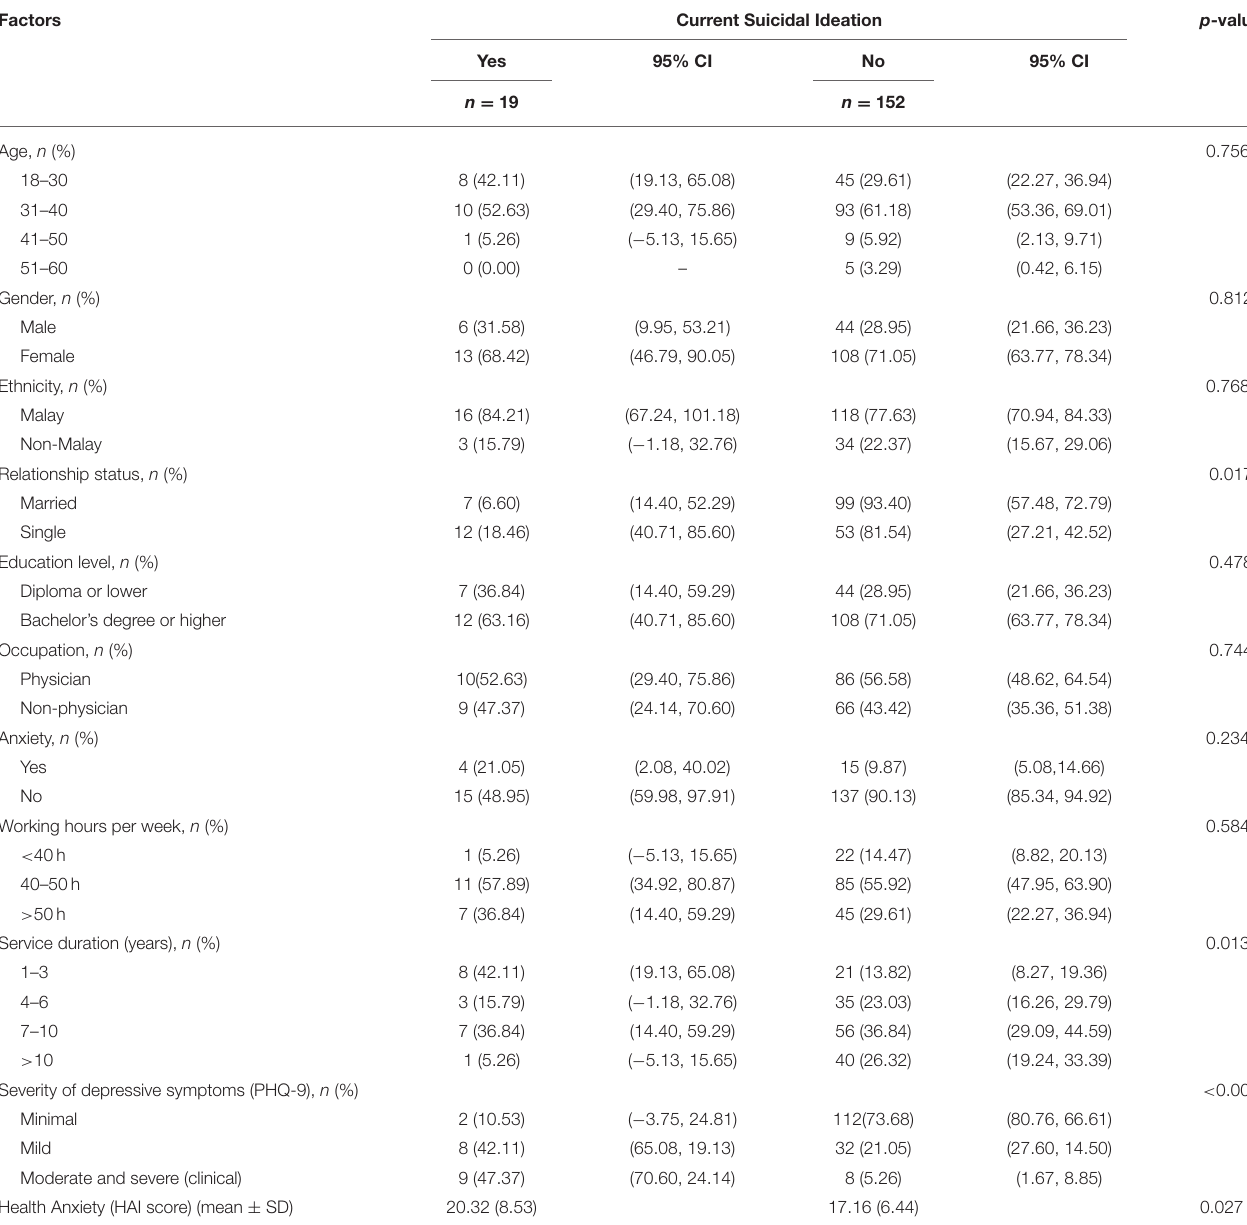
TABLE 1 | Association between socio-demographic, occupational, and clinical factors with current suicidal ideation among health care workers ( N = 171).